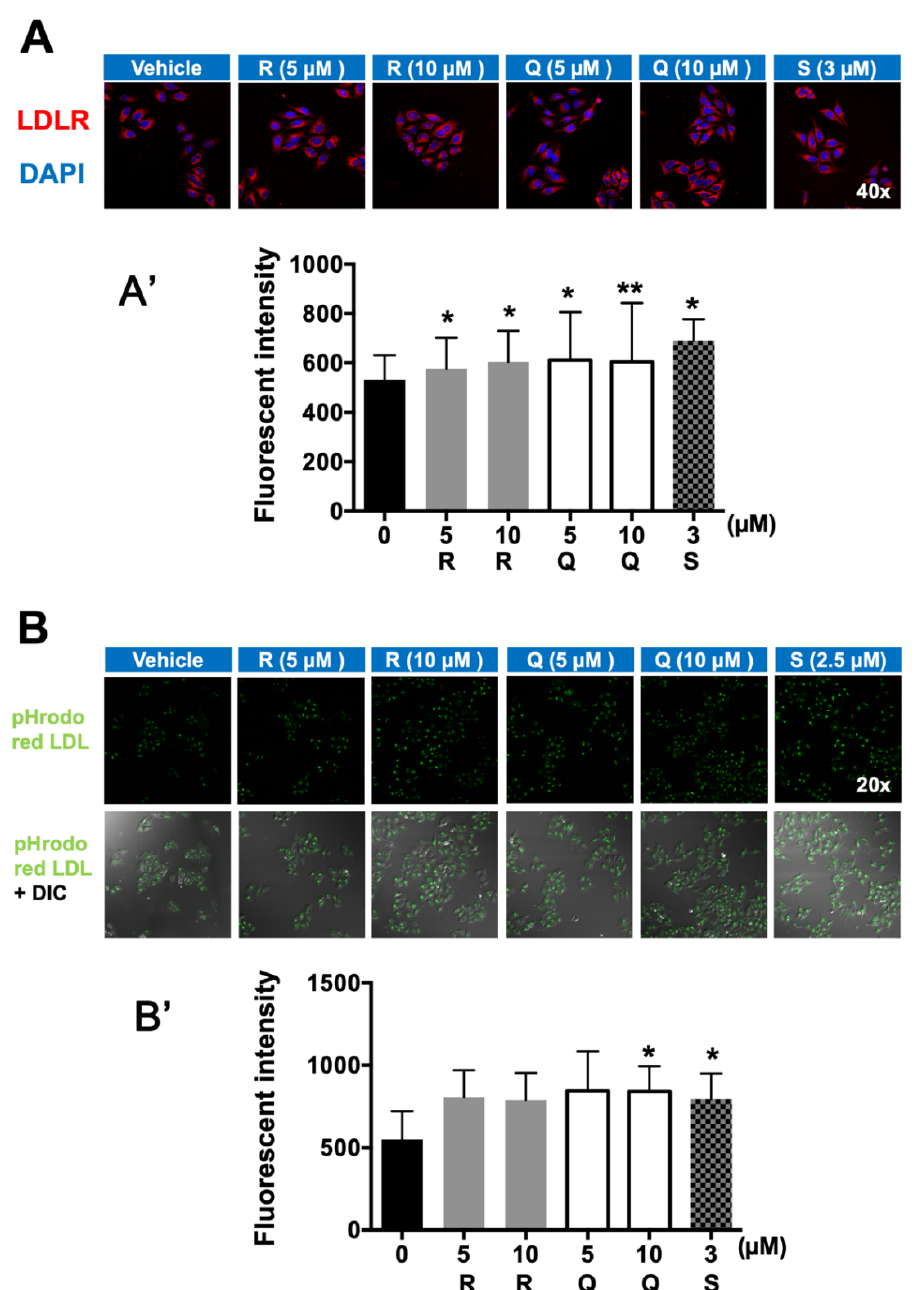
Figure 5. Effects of rutin (R) and quercetin (Q) on LDLR expression ( A , A’ ) and LDL-C uptake ( B , B’ ) determined by using an immunofluorescence staining method. Starved HepG2 cells were incubated with R, Q, or S (simvastatin) for 24 h and then immunostained with an anti-LDLR antibody. ( A ) Images of LDLR (red) and the merged images with DAPI (blue) are shown with magnification at × 400; the fluorescence intensity was quantified ( A’ ). ( B ) The HepG2 cells were starved in medium containing R and Q for 8 h and then stimulated with pHrodo red LDL-C (green) for 3 h. The photos were taken by confocal microscope with magnification at × 200; the fluorescence intensity was quantified ( B’ ). Values are expressed as means of the cellular fluorescence intensity ± standard deviations (n = 50) compared with those for the control group. ** p < 0.01 or * p < 0.05 compared with the vehicle group.